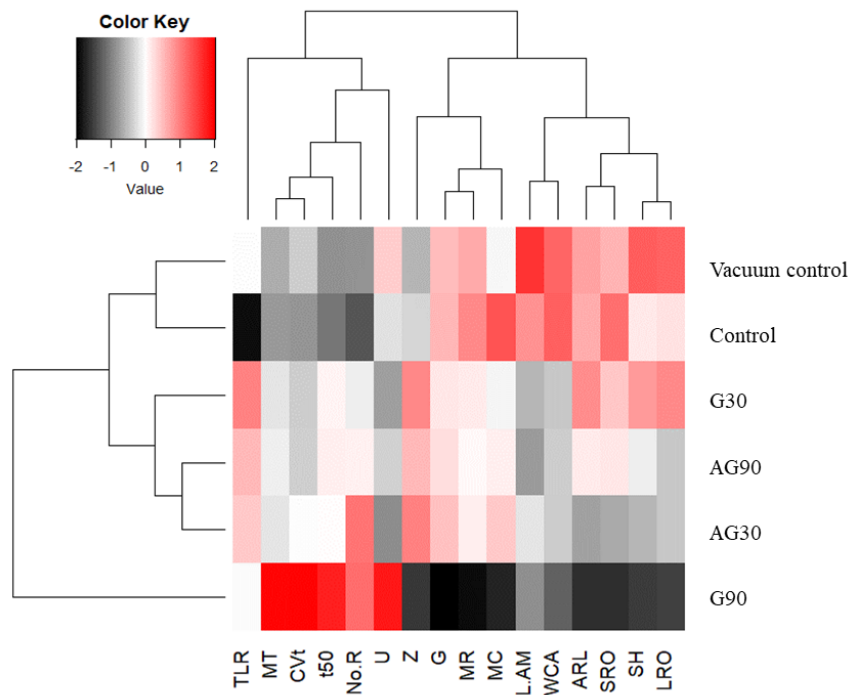
Figure 10. A two-way clustering analysis of the measured wheat parameters: Total root length per plant (TLR), mean germination time (MT), coefficient of variation of the germination time (CVt), median germination time (t50), number of roots per plant (No.R), the uncertainty of the germination process (U), synchrony of germination (Z), germination rate (G), mean germination rate (MR), moisture content (MC), α -amylase activity (L.AM), water contact angle (WCA), average root length per plant (ARL), the average length of the shortest root (SRO), shoot height (SH), and average length of the longest root (LRO). Samples seen on the right side of the heatchart are as follows: untreated seeds exposed to vacuum conditions (Vacuum control), untreated seeds (Control), and CP-treated in glow regime for 30 (G30) or 90 s (G90), and in afterglow regime for 30 (AG30) or 90 s (AG90).